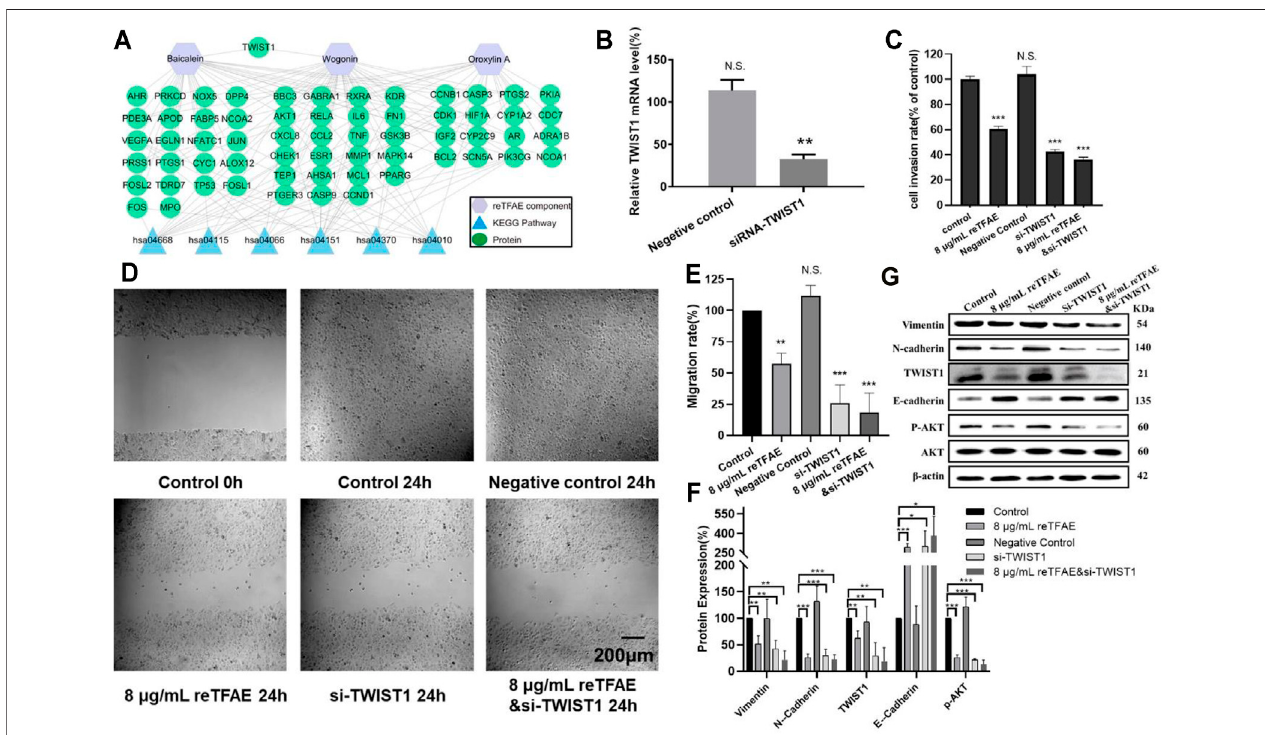
FIGURE 3| reTFAE inhibited the EMT process of A549 cells via inhibiting TWIST1. (A) Relationships of reTFAE components – KEGG pathways – Protein targets. (B) Relative TWIST1 mRNA level after siRNA interference ( n = 3). (C) . The inhibitions of siTWIST1 and reTFAE on A549 cell invasion rate ( n = 3). (D,E) The inhibitions of siTWIST1 and reTFAE on wound healing ( n = 3). (F,G) The in fl uence of siTWIST1 and reTFAE on the expression of EMT-related proteins ( n = 3). Negative control siRNA was con fi rmed not to interact with any mRNA sequence else, and was used to balance siRNA where necessary. Statistical differences were determined by a two- sided Student ’ s t -test; Compared with control, N.S., not signi fi cant, *** p < 0.001; ** p < 0.01; * p <